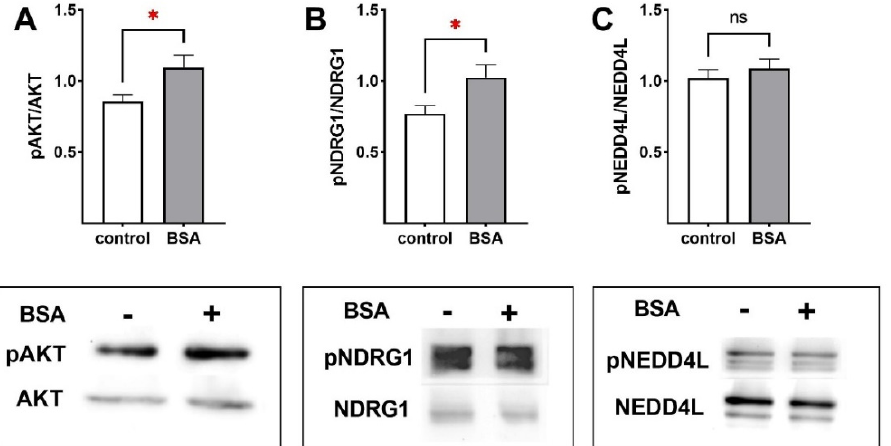
Figure 7. BSA activates PI3K/AKT/SGK1 signaling pathway. FDLE cells were cultured in MEM and stimulated with BSA (1.0 g/L) for 45 min. Data are displayed as mean + SEM. BSA significantly increased ( A ) AKT and ( B ) NDRG1 phosphorylation (n = 11–13; * p < 0.05 by t -test). Western blots of pAKT and total AKT resulted in bands of 60 kDa. Western Blot of pNDRG1 and total NDRG1 resulted in bands of 46 and 48 kDa. ( C ) Western blot of pNEDD4L and total NEDD4L resulted in bands of 110 and 135 kDa (ns = non-significant).